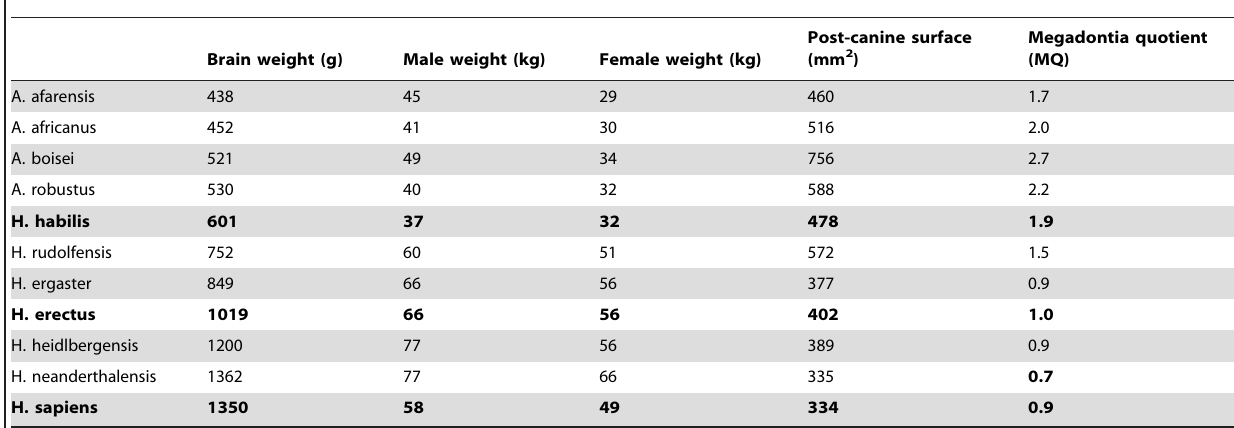
Table 1. Hominin weight and MQ estimates ([5]:258; in bold: the species on which we elaborate).